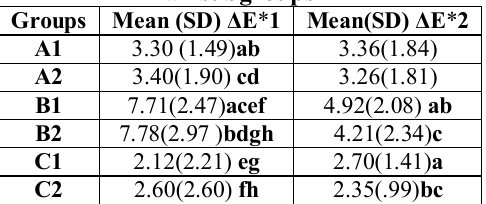
Table 3: Means (SD) of ΔE*1 and ΔE*2 for all subgroups